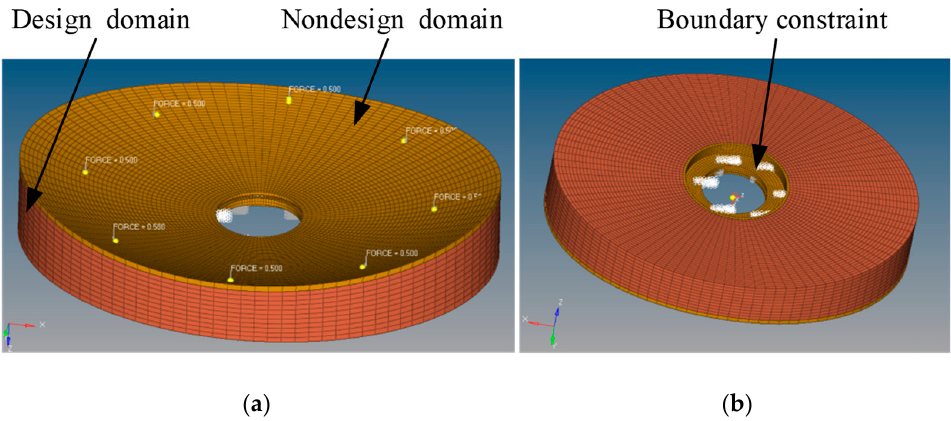
Figure 7. Establishment of initial finite element model for topology shape optimization: ( a ) division of optimization areas; ( b ) fixed support constraint.